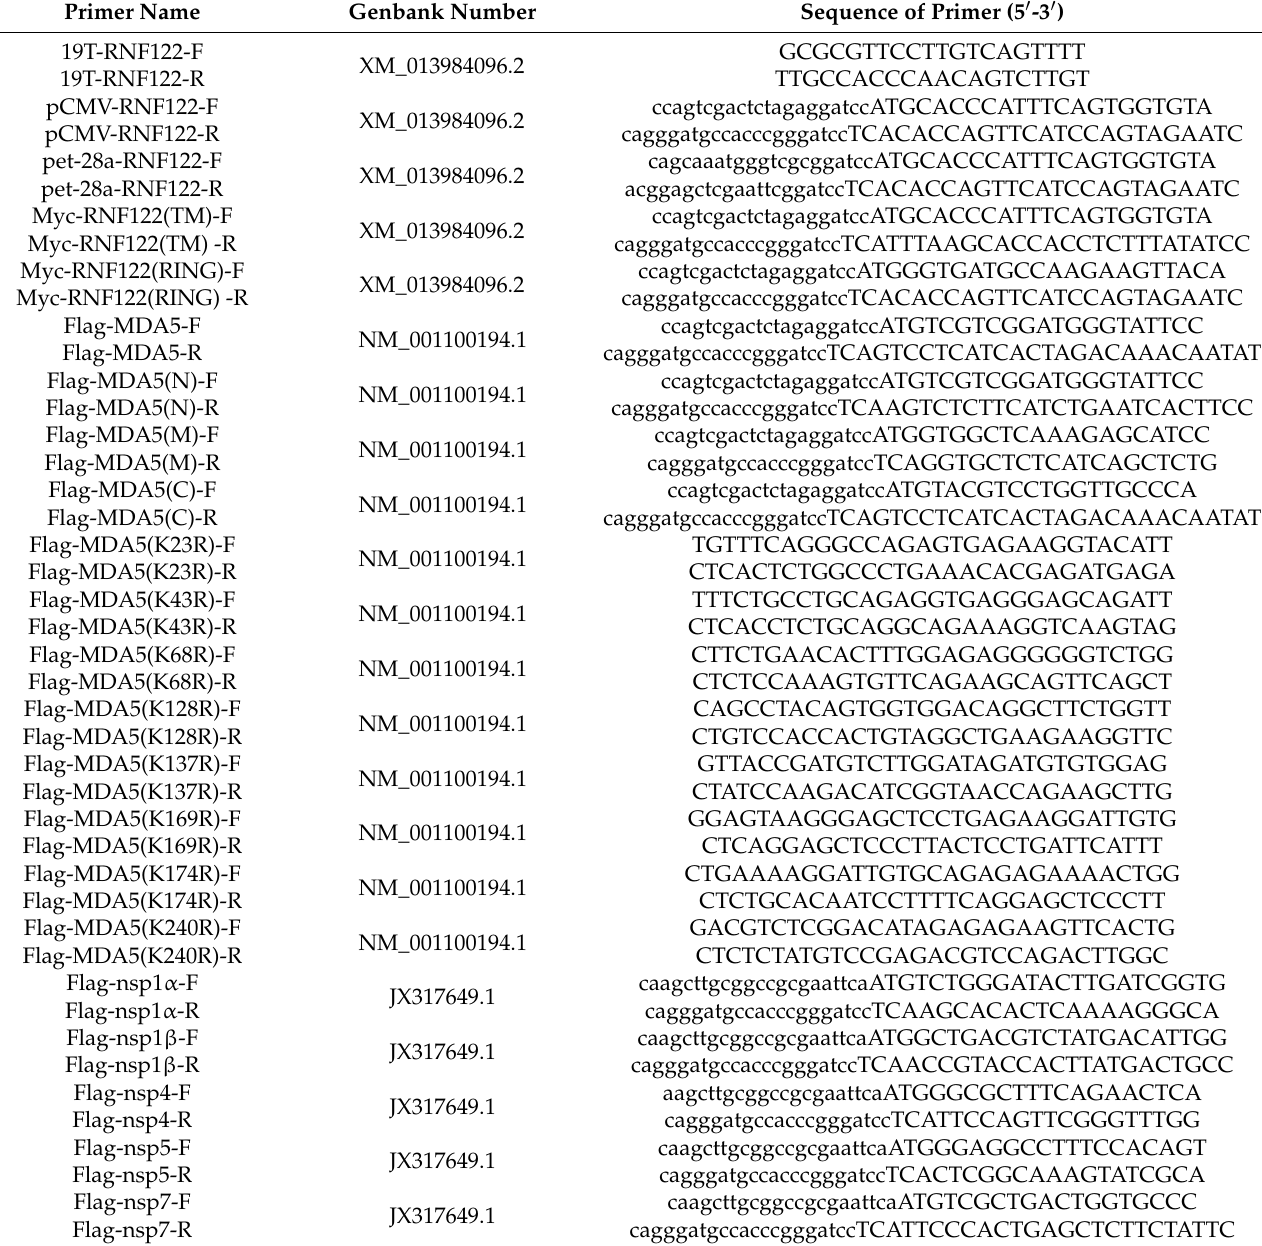
Table 1. The primers used for PCR